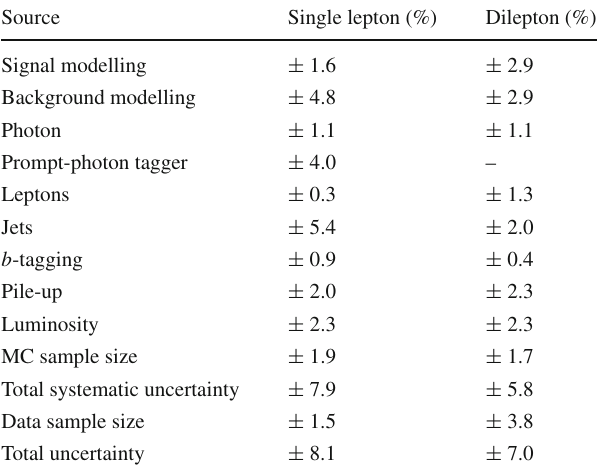
tainties on the fiducial cross-section in the single-lepton and dilepton channels. Due to rounding effects and small correlations between the different sources of uncertainty, the total systematic uncertainty is dif- ferent from the sum in quadrature of the individual